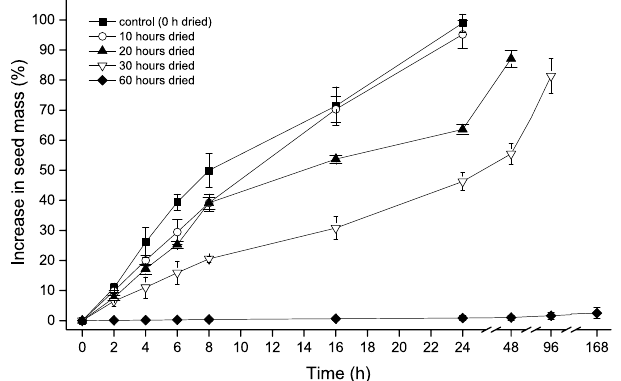
Figure 2. Percentage increase in seed mass when placed on a moist environment after being dried to different periods above silica gel. Error bars represent the standard deviation.